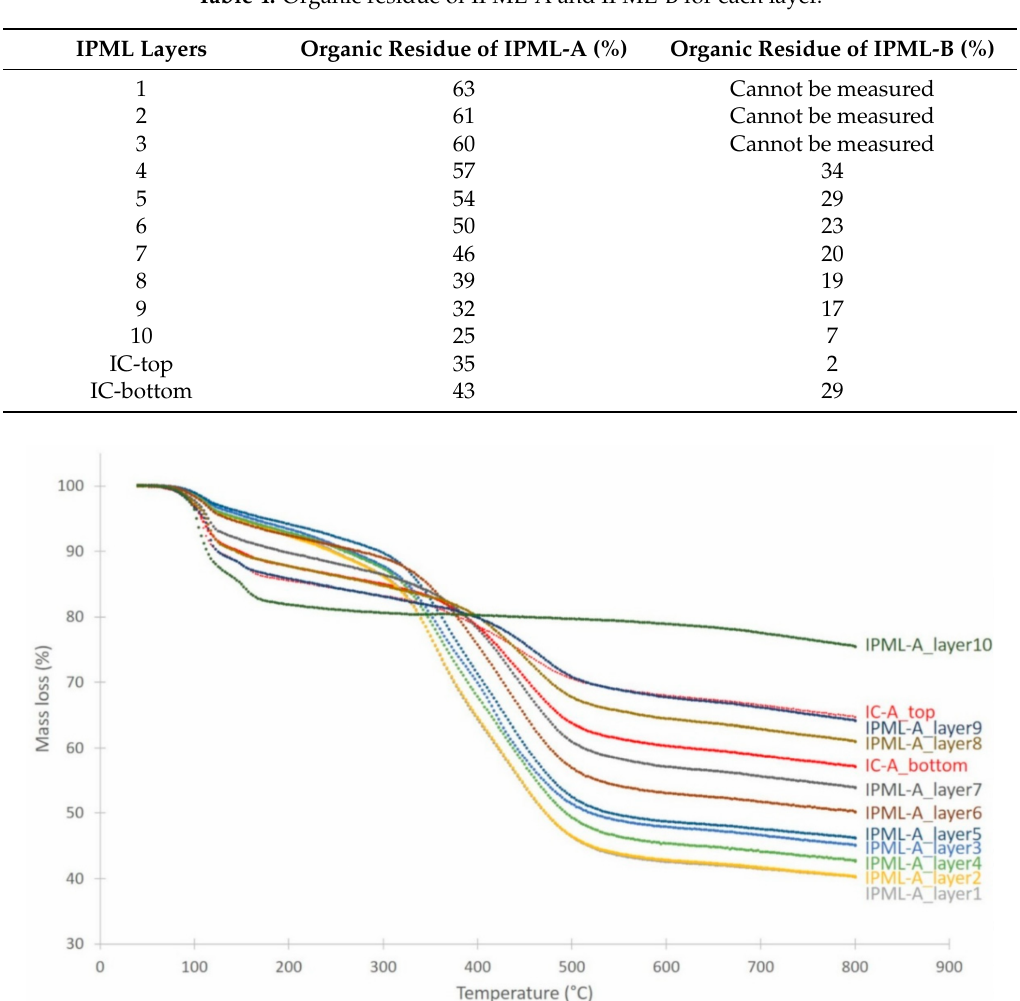
Table 4. Organic residue of IPML-A and IPML-B for each layer.